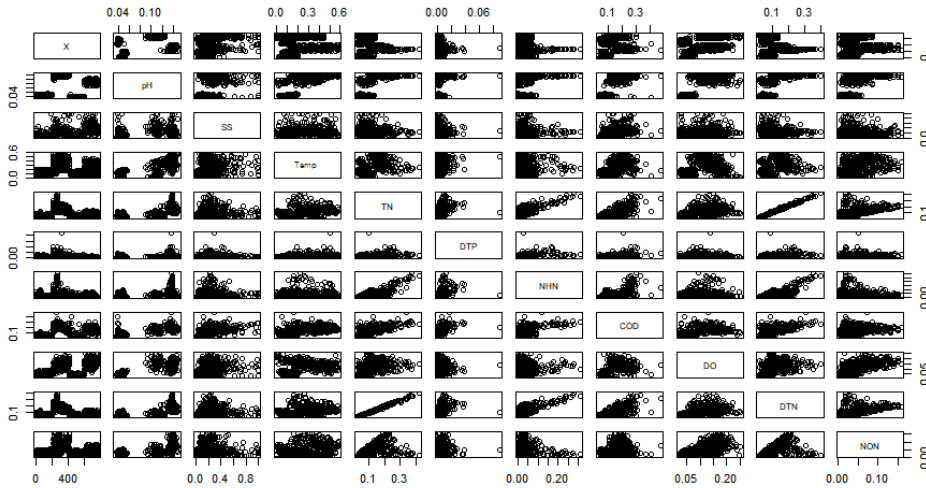
Figure 4. Visualization of the data in the Table 3. Table 3. Correlations among the water quality parameters. The following Table 4 shows the statistics of the data. Table 4. Statistics of the data.